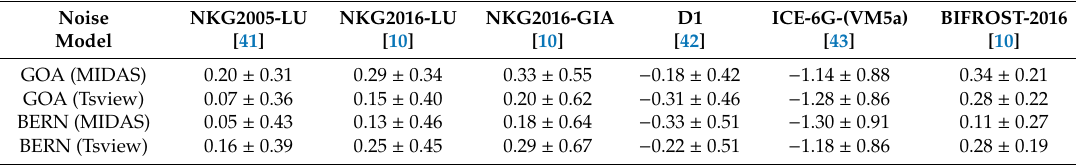
Table 7. The mean and standard deviation in mm / yr of the Up velocity residuals from di ff erent LU and GIA models based on the MIDAS and Tsview